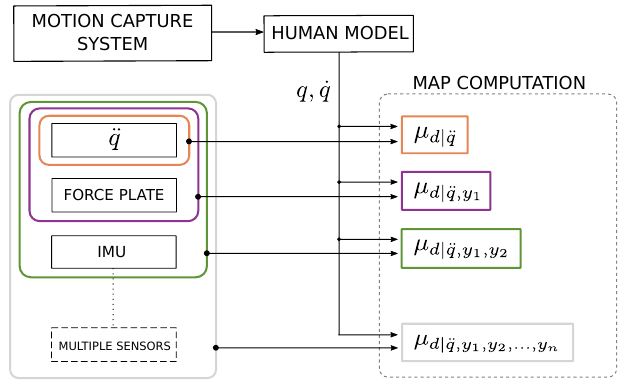
Figure 3. General scheme of the experimental set-up including a motion capture system and a block of sensors. Data coming from the motion system were used as inputs for each Maximum-a-Posteriori (MAP) computation and, progressively, sensor measurements ( ¨ q , force plate sensing and inertial sensor IMU) were added to compute a more complete version of MAP. Although only three sensors are used (the ‘multiple sensors’ block is not present in this version of experiment), in general, the set-up can embed n sensors and exploit their measurements to enhance the dynamic estimation of d .